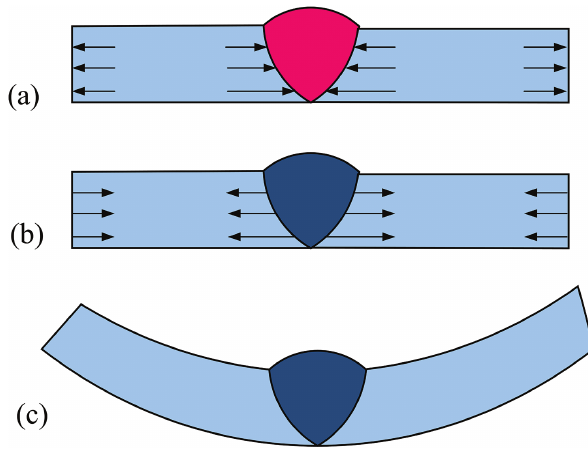
Figure 10: Schematic for the formation of the weld bowing distor- tion. (a) Force diagram of the weldment during the heating process of welding. (b) Force diagram of the weldment during the cooling process of the welding. (c) The plate exhibiting weld bowing distortion.